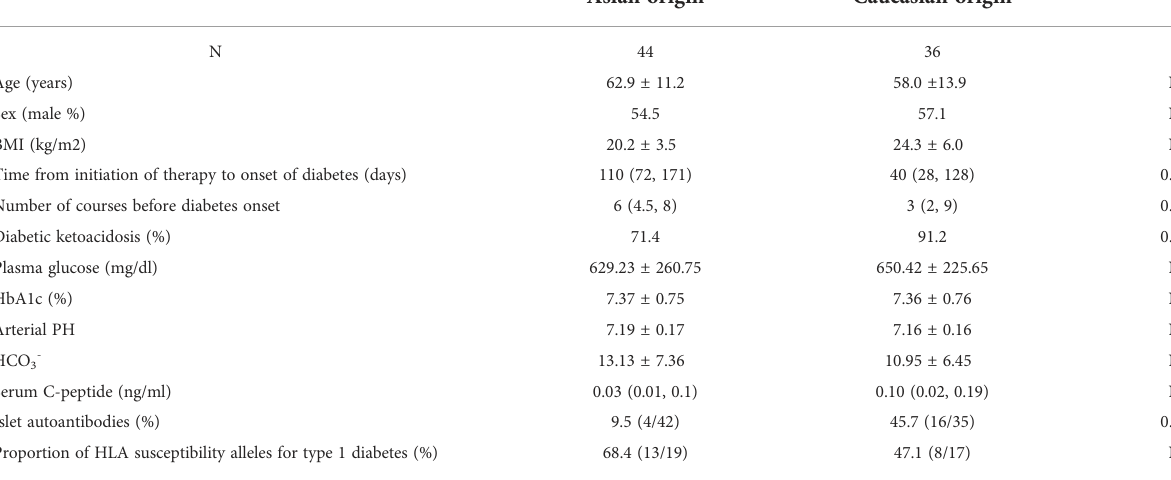
TABLE 4 The clinical and biological characteristics of IFD in different ethnic origin.